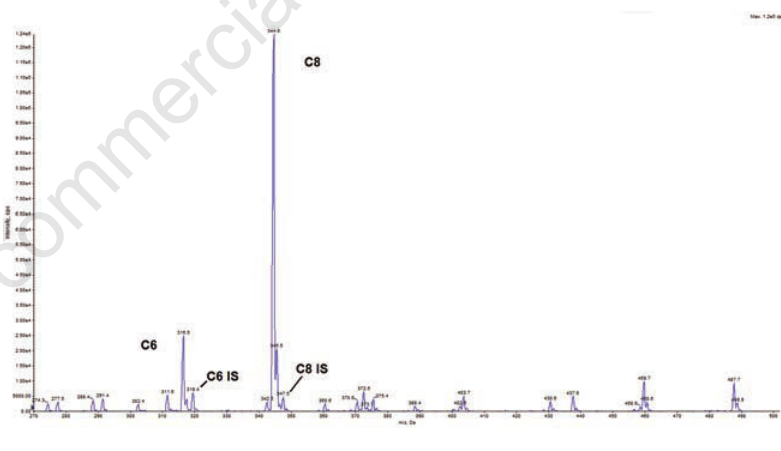
Figure 1. Acylcarnitine tandem mass spectrometry profile of MCAD-affected Patient at day 7 of life. Tandem mass spectrometry assessment of acylcarnitine esters. C8 = eight car- bon acylcarnitine ester, C8 IS = stable isotope labeled eight carbon acylcarnitine internal standard, C6 = six carbon acylcarnitine ester, C6 IS = stable isotope labeled six carbon acylcarnitine internal